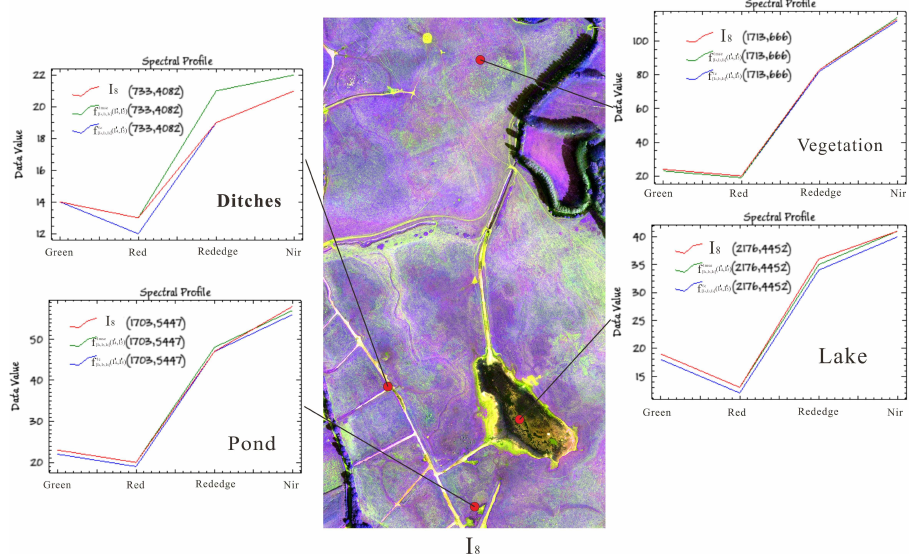
Figure 13. Spectral curves between scene interpolated result and reference scene image using different loss functions at different coordinates in August